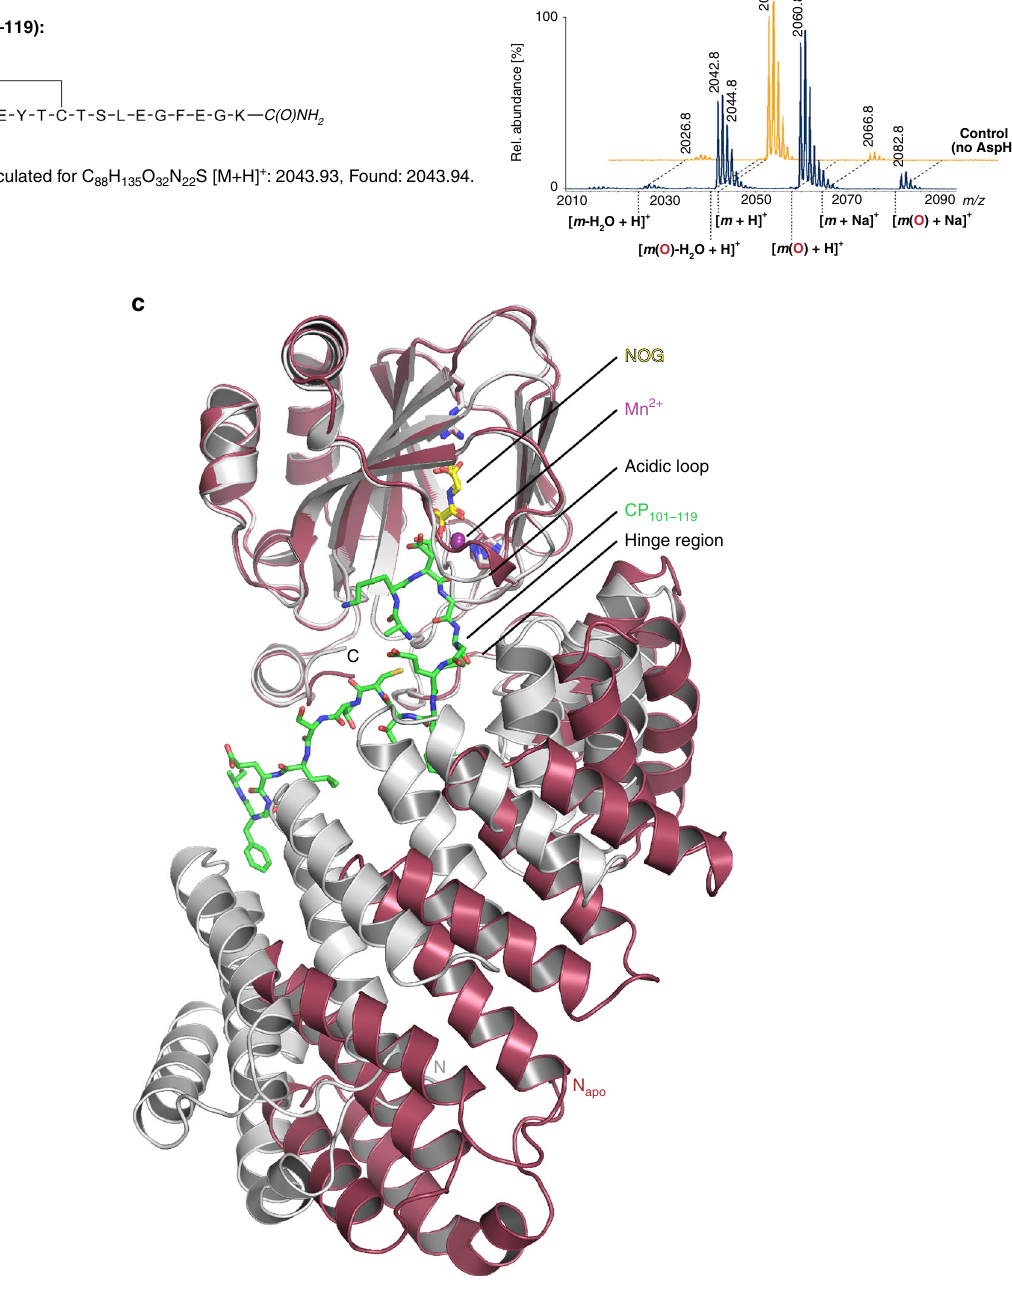
Fig. 6 A cyclic peptide mimicking the non-canonical Cys3 – 4 EGFD is an excellent AspH-substrate. End-point turnover reactions were performed as in the Methods Section. a Schematic structure and calculated mass of the cyclic peptide CP 101 – 119 mimicking the central macrocyclic disul fi de of the non-canonical isomer of hFX EGF1 39mer (Cys3 – 4); the hydroxylation site (Asp103 hfX ) is in red. b >95% Hydroxylation of the CP 101 – 119 peptide was observed